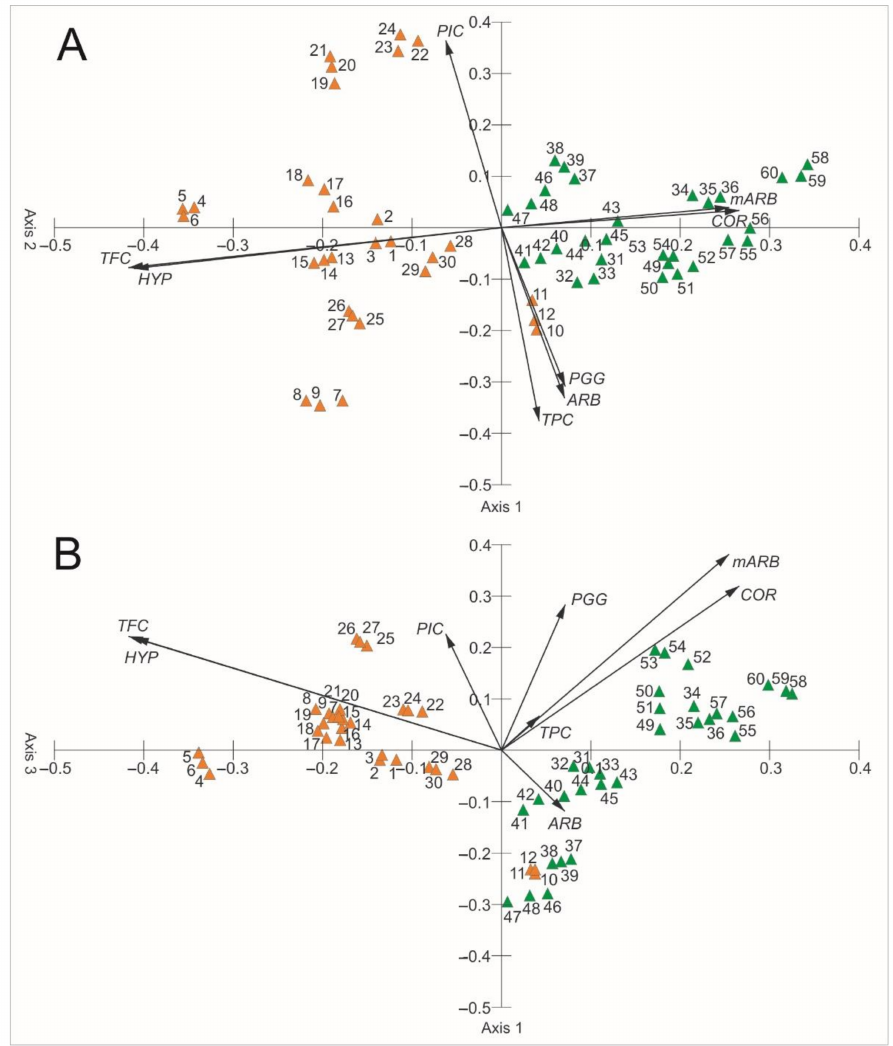
Figure 11. Results of PCA based on the chemical composition of bearberry leaf extracts. A—Axis 1 and Axis 2, B—Axis 1 and Axis 3, ARB—arbutin, mARB—methylarbutin, PGG—penta-O-galloyl- β - D -glucose, HYP—hyperoside, PIC—picein, COR—corilagin, TPC—total phenolic content, TFC—total flavonoid